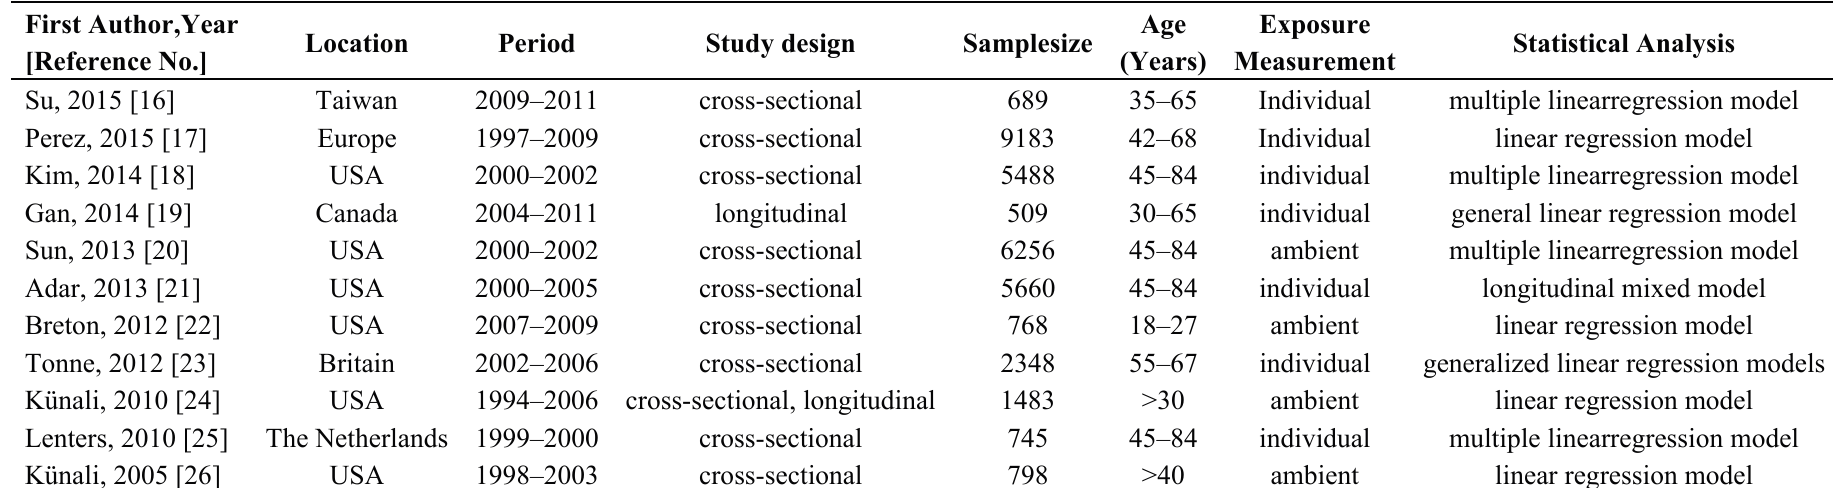
Table 1. Characteristics of included